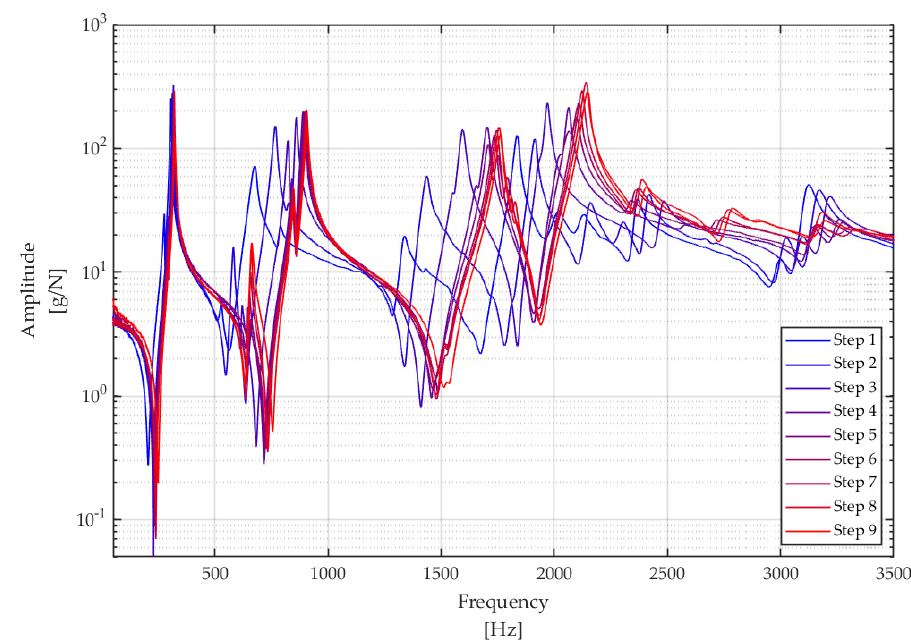
Figure 5. Comparison of FRFs corresponding to subsequent insertion steps without soft tissue in the ML direction.